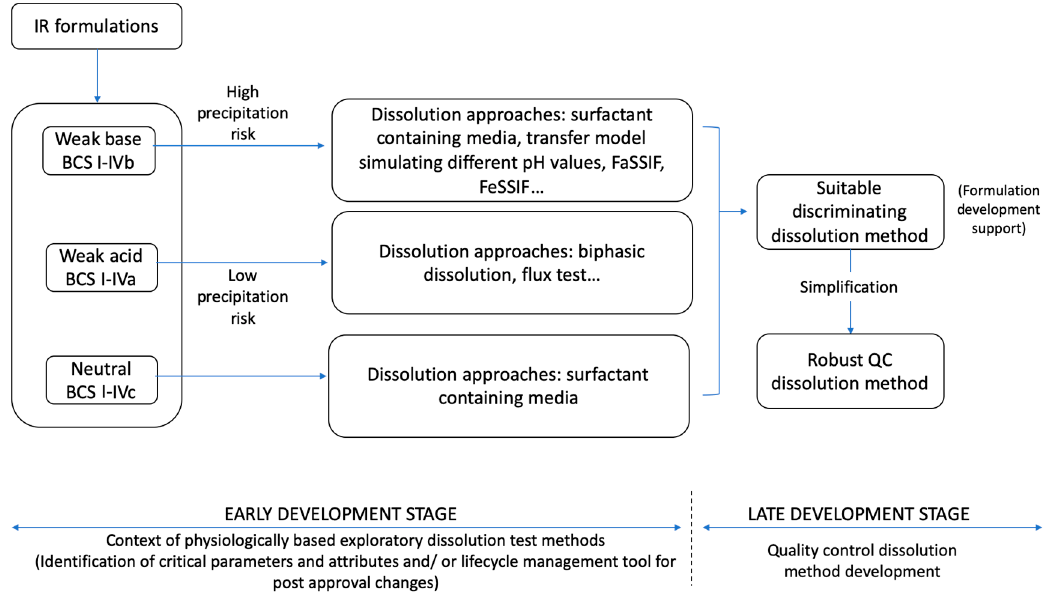
Figure 1. Simplified approach for dissolution method development for immediate release (IR) formulations containing acidic and basic drugs (BCS I–IV). FaSSIF: Fasted State Simulated Intestinal Fluid; FeSSIF: Fed State Simulated Intestinal Fluid; BCS: Biopharmaceutics Classification System.